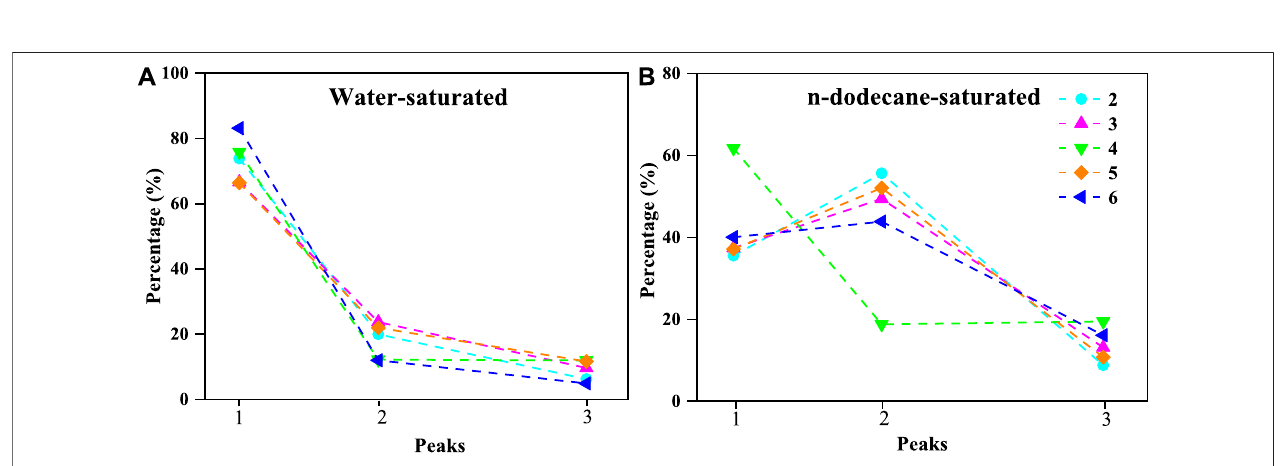
FIGURE 11 | Peak area percentage of three peaks (P1, P2, and P3) for (A) DIW- and (B) dodecane-saturated Samples 2 – 6.